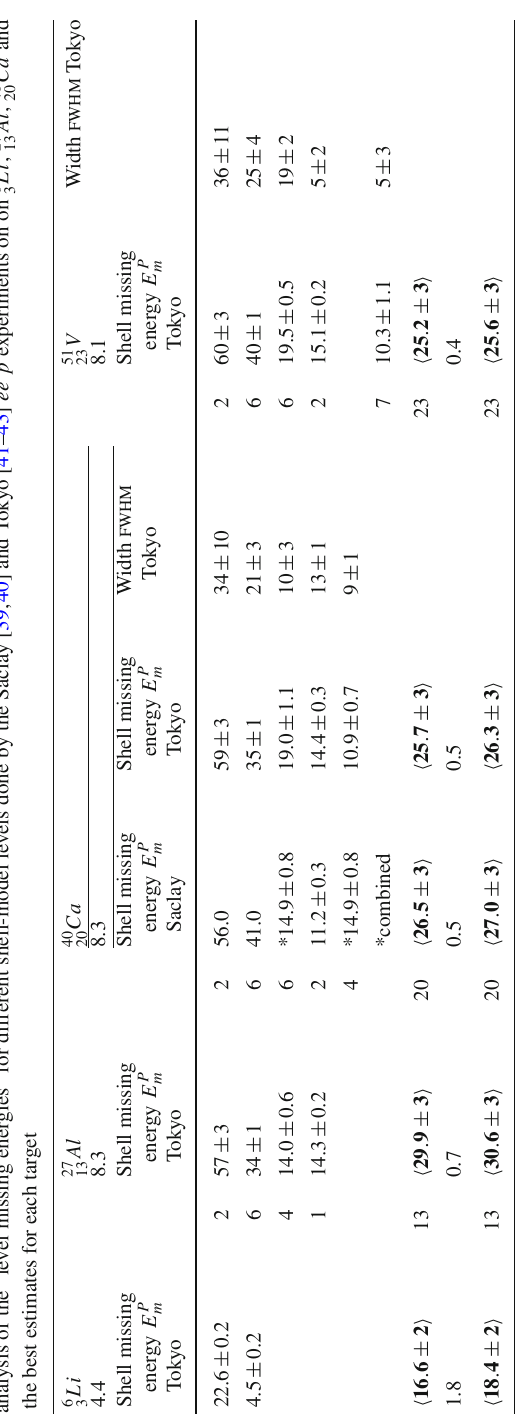
) 2 ( k P , N 3 F 5 2 M